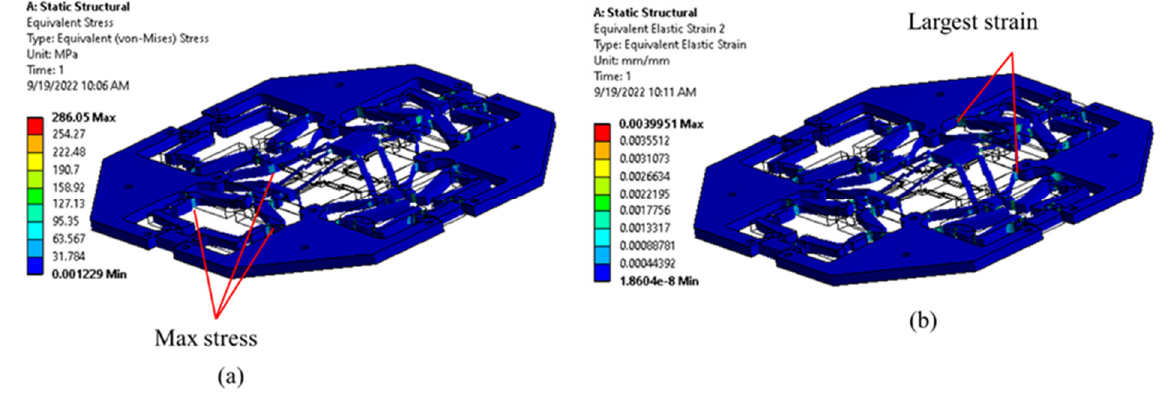
Table 4. Numerical results (Input displacement of 79 µm). Figure 8. Simulation of XYZ micropositioner: ( a ) stress, and ( b ) strain. Figure 8. Simulation of XYZ micropositioner: ( a ) stress, and ( b )